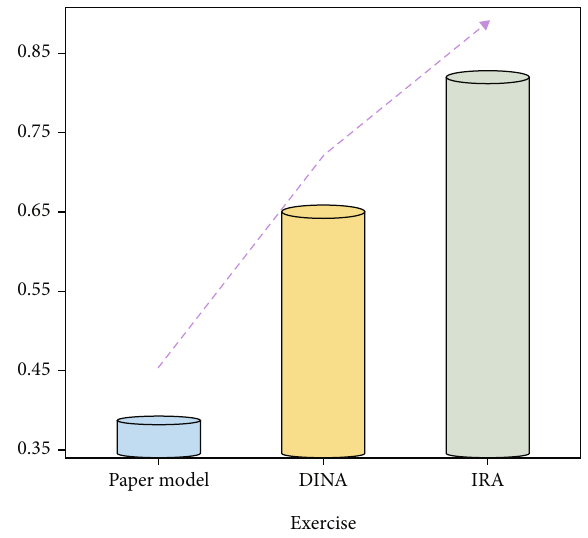
Figure 7: Comparison results of exercise list recommendation e ff ects of three exercise recommendation